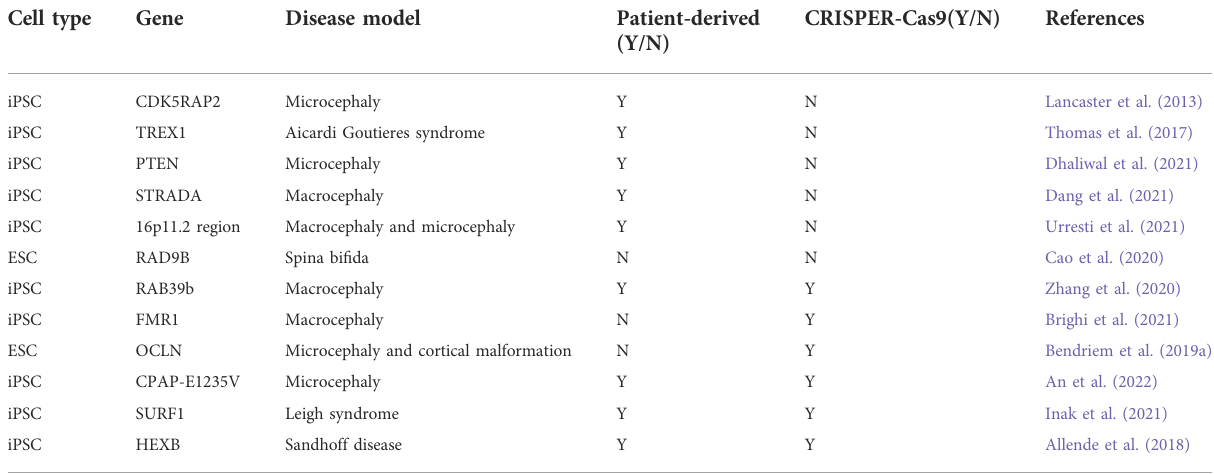
TABLE 1 Application of brain organoid models and/or CRISPER-Cas9 in